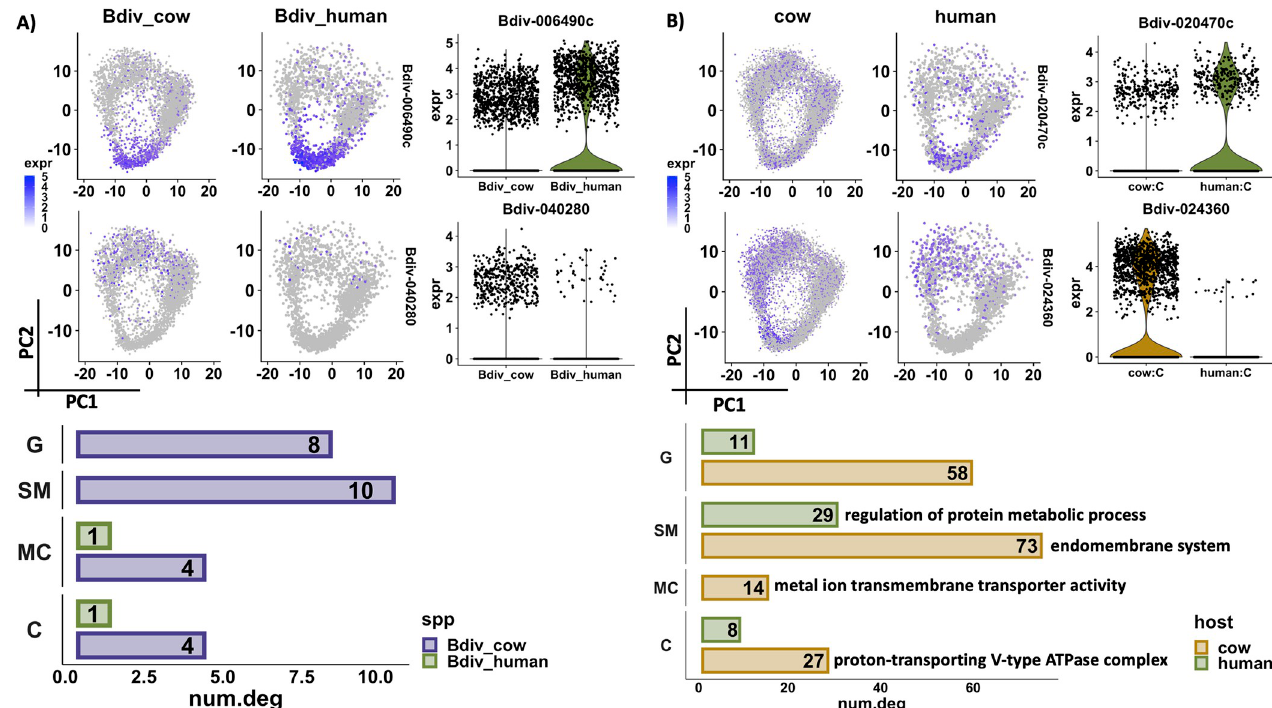
Fig 6. Host-specific differential expression and GO term enrichment analysis. (A) Top: Expression of top differentially expressed genes in B . divergens in bovine and human RBCs. Violin plots illustrate the distribution of expression of the top DEGs. Bottom: Bar plots showing the total number of DEGs in the indicated phase (rows) in each sample (colors). (B) Top: Expression of top DEGs in combined B . bigemina , B . bovis , and B . divergens in bovine RBCs versus B . divergens in human RBCs. Violin plots illustrate the distribution of expression of top DEGs. Bottom: Bar plots showing the total number of DEGs in the indicated phase (rows) in each sample (colors). To eliminate the confounding effect caused by species differences, any DEG between B. divergens AU : Ihavechangedallinstancesof “ B : divergence ” to “ B : divergens : ” Ifthisisnotcorrect ; pleaseeditasnecessary : and B . bigemina or between B . divergens and B . bovis in bovine RBCs was excluded from this analysis. The topmost significant GO term associated with each set of DEGs (Benjamini < 0.1) is presented next to the bar plot. DEG, differentially expressed gene; GO, Gene Ontology; PC, principal component; RBC, red blood cell. Data and code for generating the figure are available at https://github.com/umbibio/scBabesiaAtlases.